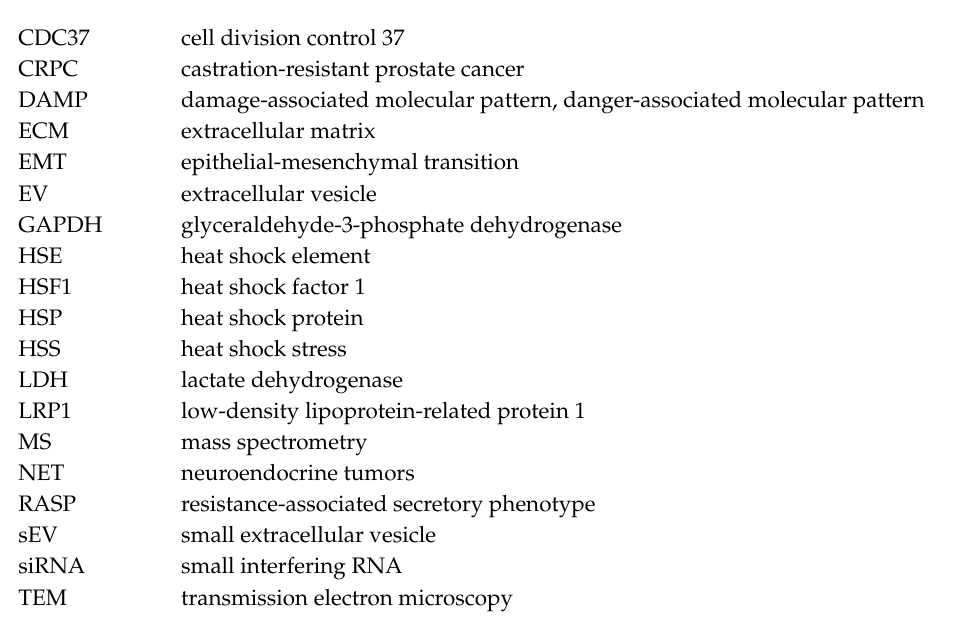
Figure S1. Western blotting showing E-cadherin, N-cadherin, and GAPDH, supporting Figure 1A; Figure S2. Western blotting showing EV-HSP90 α , -CD9, - β -actin, Cell-HSP90 α , -CD9, and – β -actin, supporting Figure 1D; Figure S3. Full views of TEM, supporting Figure 2A,B; Figure S4. Heat shock stress-induced EVs(100–500 nm) in culture media of PC-3 cells; Figure S5. Full views of cellular photomicrographs, supporting Figure 2F–H; Figure S6. Western blotting showing CDC37, HSP90 α , HSP90 β , CD9, and GAPDH, supporting Figure 4H; Figure S7. Western blotting showing EV-CD9, EV-GAPDH, Cell-CDC37, and Cell-GAPDH, supporting Figure 5A; Figure S8. Western blotting showing HSP90 α , HSP90 β , CDC37, E-cadherin, Vimentin, and GAPDH, supporting Figure 6A; Figure S9. Knockdown of CDC37 and HSP90alpha reduced EV(200–1000 nm); Figure S10. Western blotting showing CDC37, HSP90 α , HSP90 β , and GAPDH, supporting Figure